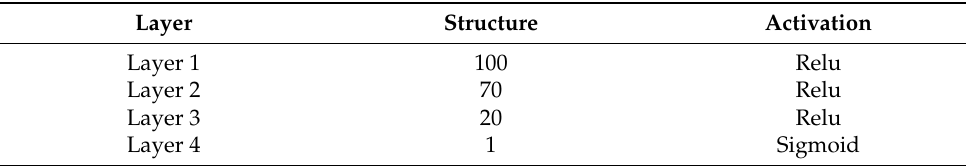
Figure 17. Decision fusion network. Table 7. Decision fusion network structure.